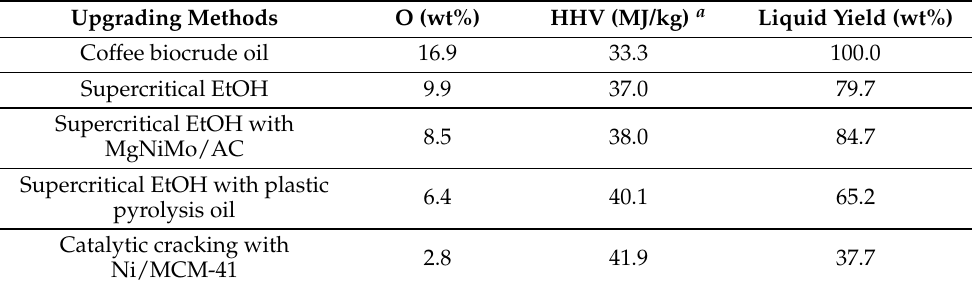
Table 6. Oxygen contents, heating values, and liquid yields of upgraded coffee biocrude